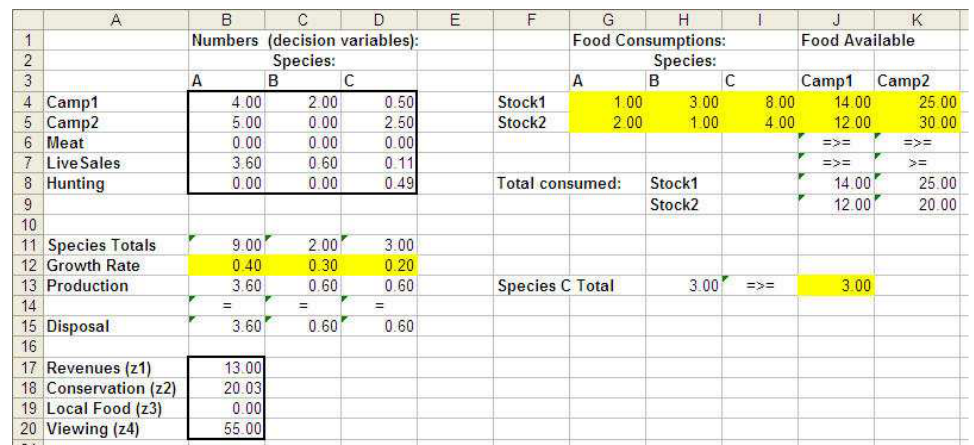
Figure 1: Spreadsheet set-up for the game reserve planning